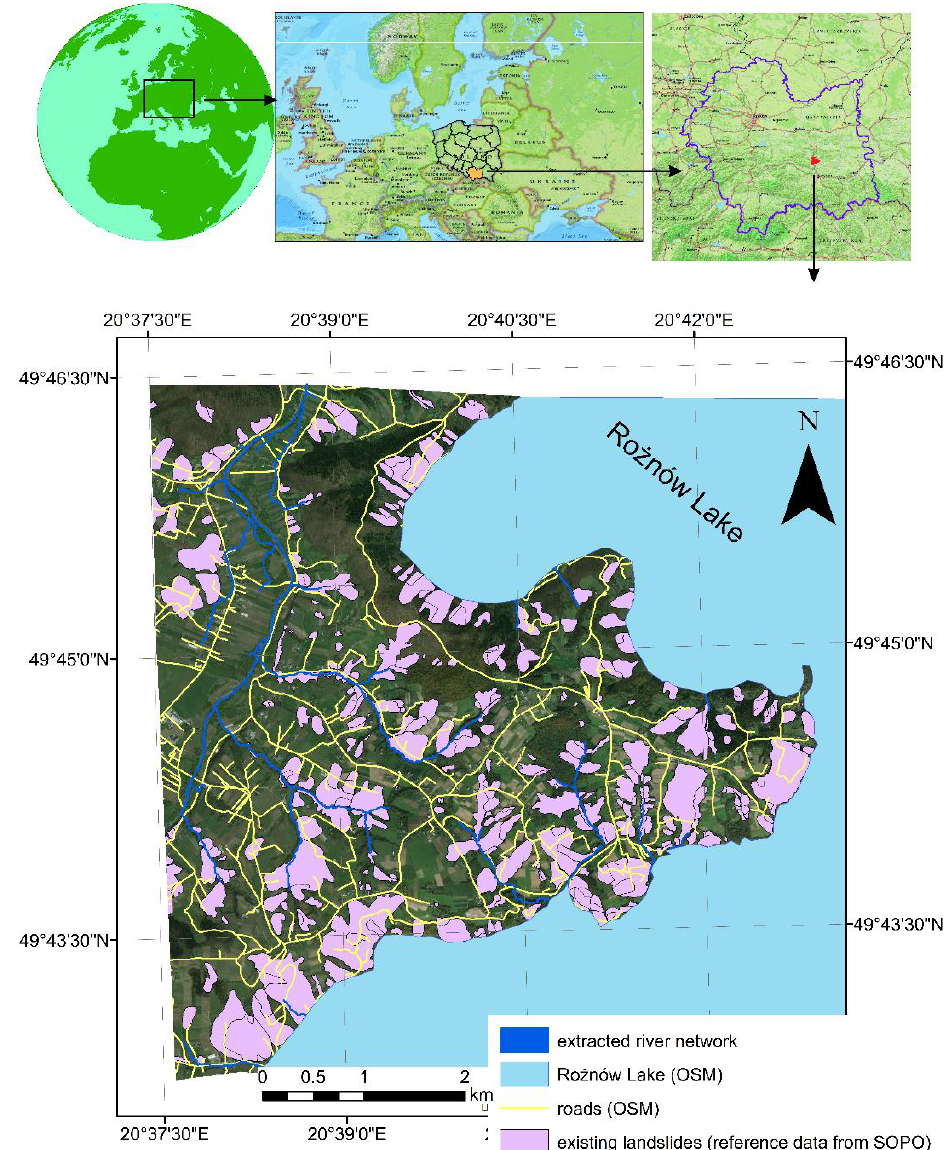
Figure 1. Study area location within Poland and existing landslides overlap to an RGB orthophoto. Landslides are obtained from the National landslide database (SOPO) and additional auxiliary data.